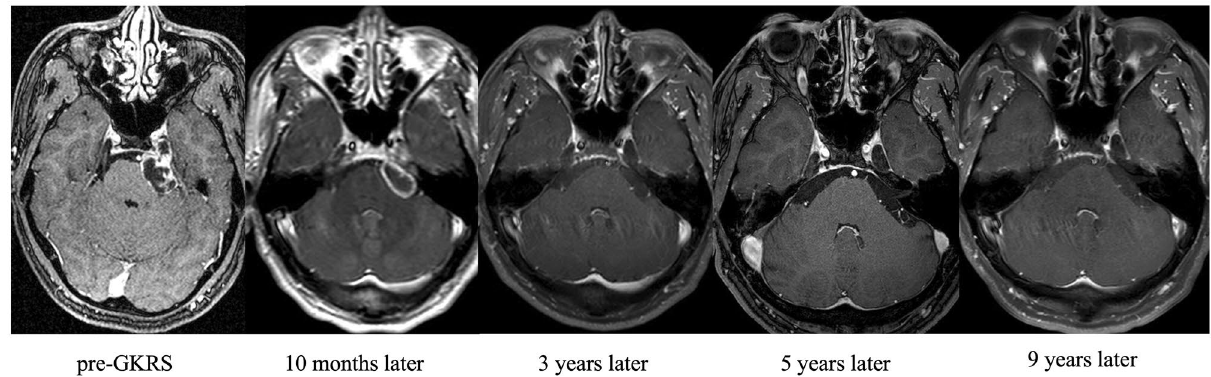
Figure 2. Illustrative case showing a gradual decrease in tumor size after GKRS (12 Gy, 50% isodose line, 6.3 cm 3 ). A 43-year-old male improved facial hypesthesia as well as radiographic finding 9 years after GKRS. Initial MRI showed the tumor occupied Meckel’s cave and prepontine cistern, and compressed brainstem. It was gradually decreased, and it was completely diminished at 9 years post-GKRS. GKRS, gamma knife